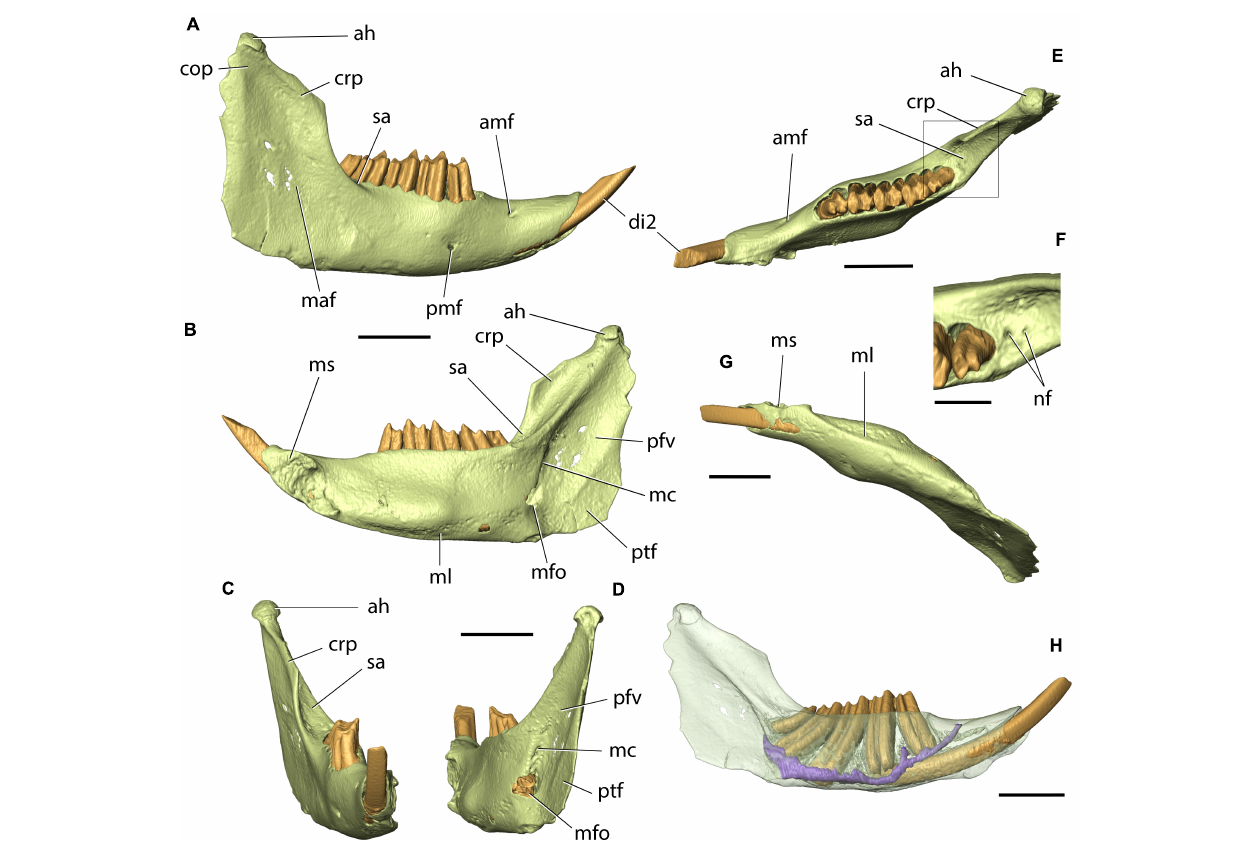
FIGURE 12 | Right mandible of Palaeolagus haydeni (FMNH PM9476) in (A) lateral, (B) medial, (C) anterior, (D) posterior, (E) dorsal, and (G) ventral views. Inset in (F) shows detail of area posterior to m3 outlined in (E) . (H) Shows the position of teeth and mandibular canal (purple) within the bone. ah, articular head; cop, condyloid process (broken); crp, coronoid process (broken); di2, lower incisor; maf, masseteric fossa; mc, external foramina of maxillary canal; amf, anterior mental foramen; ml, mylohyoid line; mfo, mandibular foramen; ms, mandibular symphysis; nf, neurovascular foramina; pfv, pterygoid fovea; pmf, posterior mental